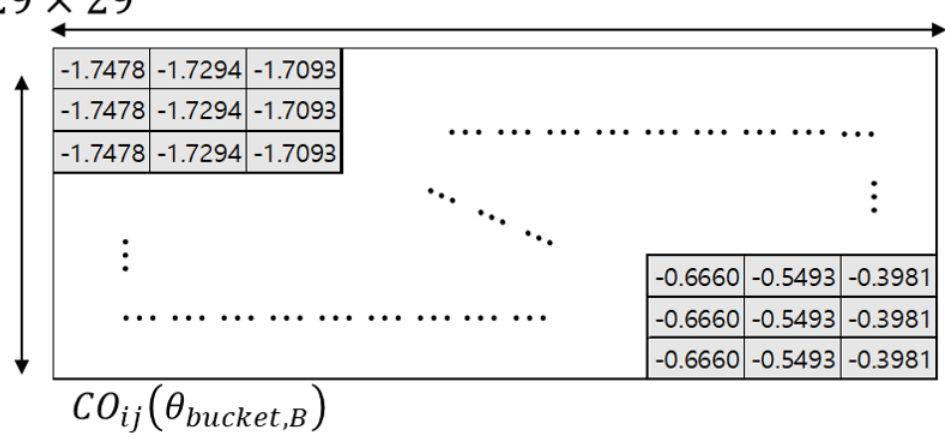
Figure 13. The 29 by 29 matrix about CO ij ( θ stick , B ) .